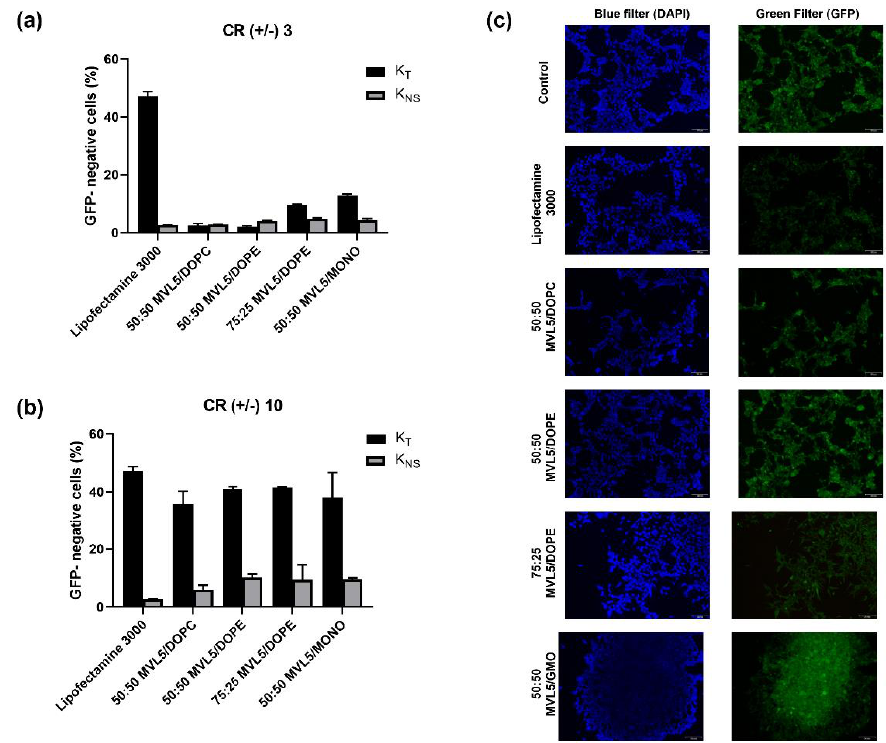
Figure 5. GFP gene disruption assay in HEK 293T-GFP cells, measured 72 h after treatment with CL-DNA complexes and Lipofectamine 3000. ( a , b ) Total (K T ) and non-specific (K NS ) gene silencing effi- ciency of MVL5-based lipoplexes at a CR ( +/− ) of 3 and 10, respectively. The percentage of GFP- negative cells was measured by flow cytometry. The data are expressed as the mean± SD ( n = 2). K T is measured with the PX459-sgRNA-GFP and K NS is measured with the PX459 empty vector. ( c ) Fluorescence microscopy images of HEK 293T-GFP cells transfected with MVL5-lipoplexes at a CR ( +/− ) of 10. Scales bars correspond to 100 µm.